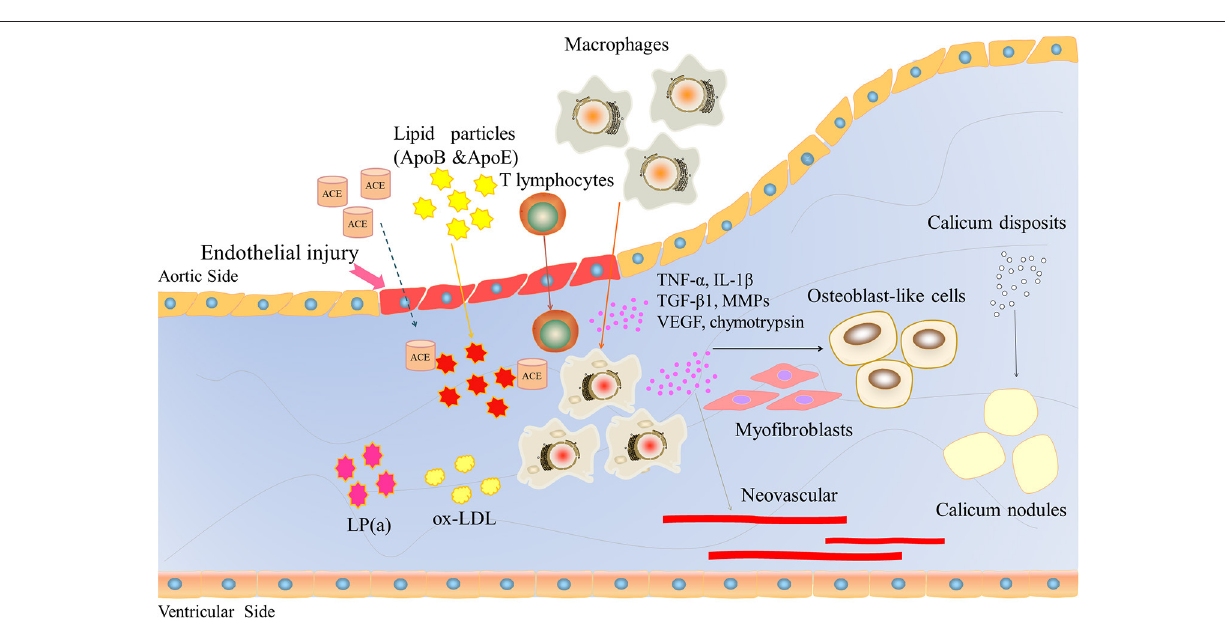
FIGURE 2 | The role of inflammatory factors in regulating CAVD development and progression. Endothelial injury induces lipid particles (ApoB and ApoE), T lymphocytes and macrophages into the valve and releases large inflammatory factors, such as TNF-a, IL-1 β , TGF β 1, and VEGF. VEGF induces neovascularization. These inflammatory factors lead to osteoblast-like cells, ultimately inducing calcium